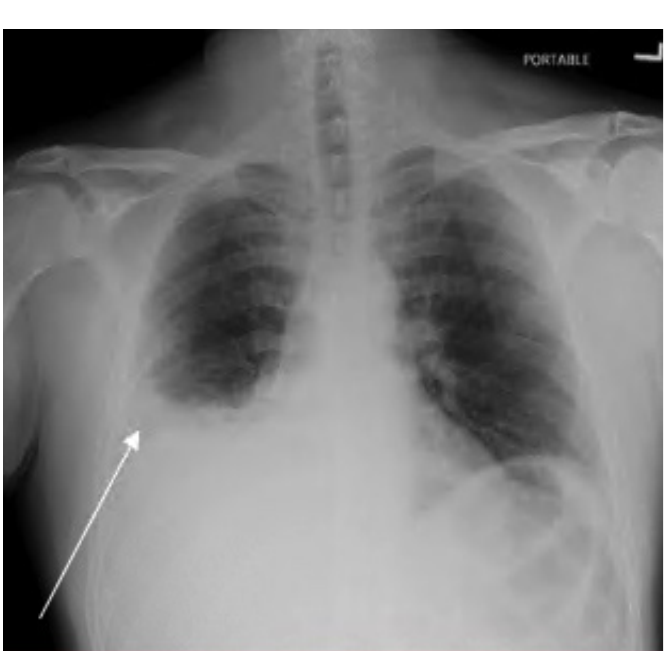
Image 1. Chest radiograph. Arrow pointing at right-sided pleural